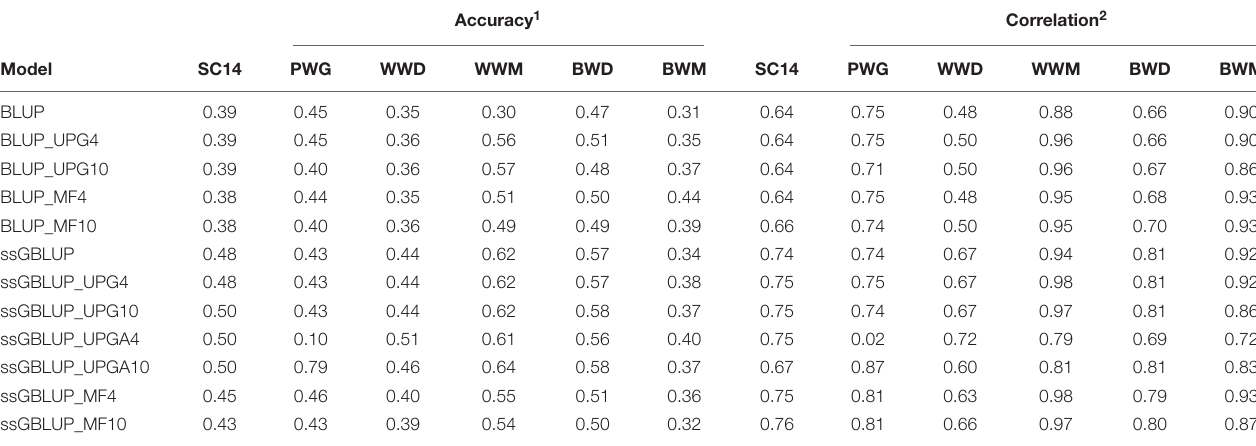
Table 4 shows accuracies of direct and maternal (G)EBV for the 436 validation animals. Accuracies of direct (G)EBV were largely similar across pedigree-based models and across genomic models for all traits. On the other hand, accuracies of maternal (G)EBV were higher for pedigree-based models with UPGs or MFs. Adding UPGs to A and A 22 (ssGBLUP_UPGA) showed greater changes in accuracy for PWG when compared with other genomic models. The accuracy of (G)EBVs ranged from